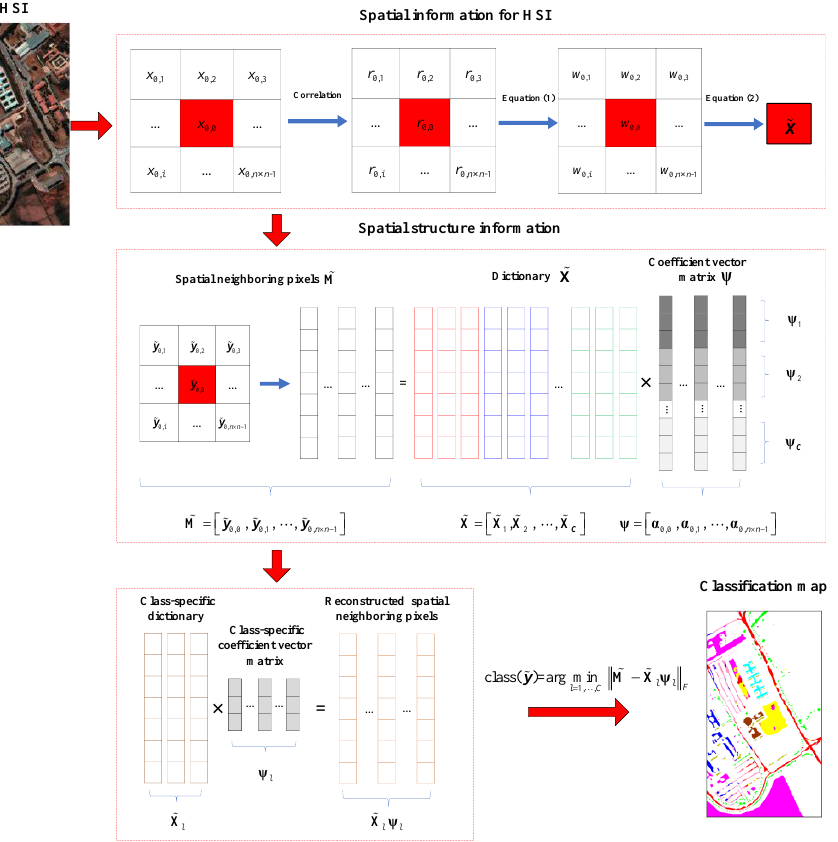
Figure 3. The flowchart for the proposed WSSJCRC method.